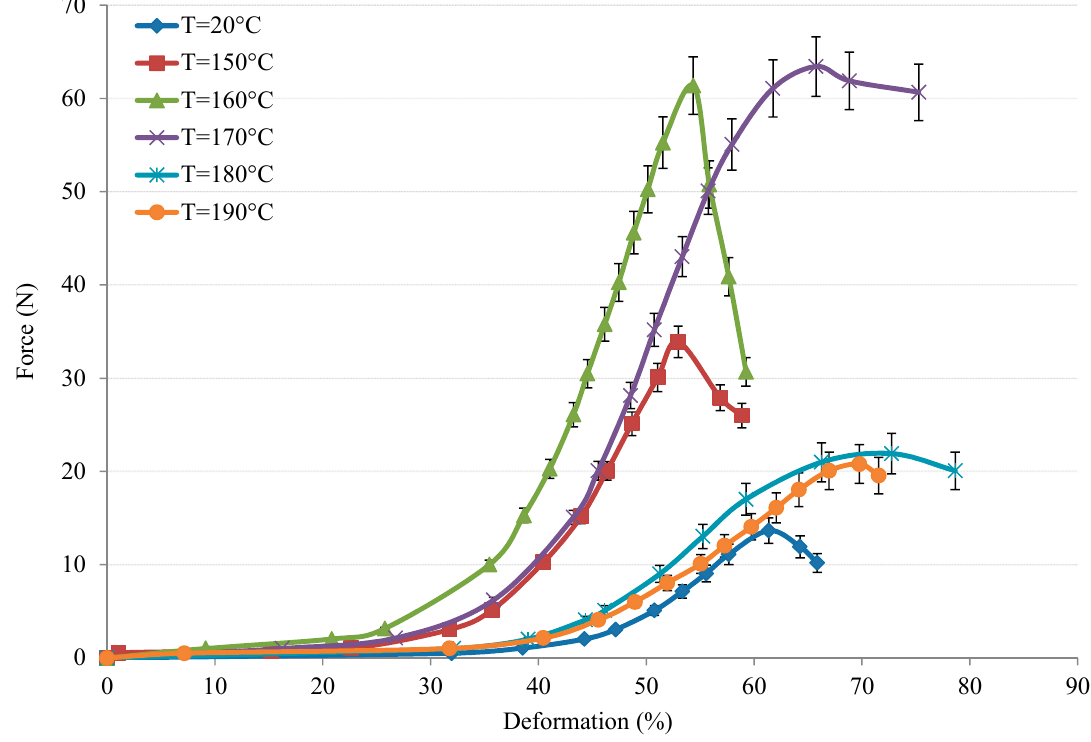
Figure 8. The load vs. deformation under variation of temperature.